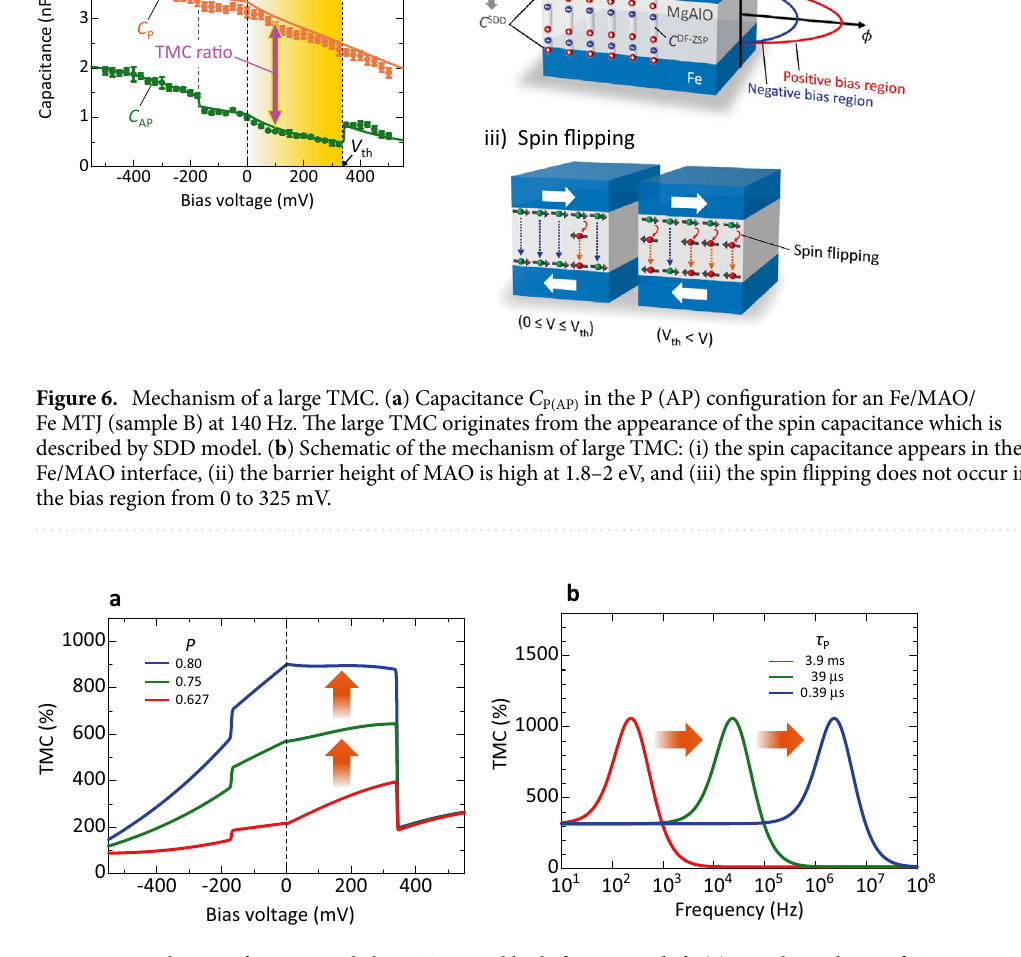
Figure 7. Prediction of an extremely large TMC and high-frequency shift. ( a ) Bias dependence of TMC at 140 Hz with varying spin polarization P TMC . TMC is enhanced in higher spin polarization. ( b ) Frequency characteristics of TMC at 325 mV with varying the relaxation time τ P . The large TMC of 1060% is shifted to the high frequency region for short τ P